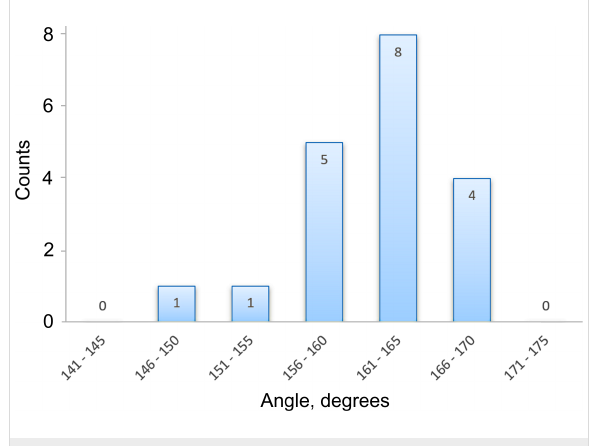
Figure 5: Distribution of angles of the deformed NWs after an abrupt plastic event in the bending tests.